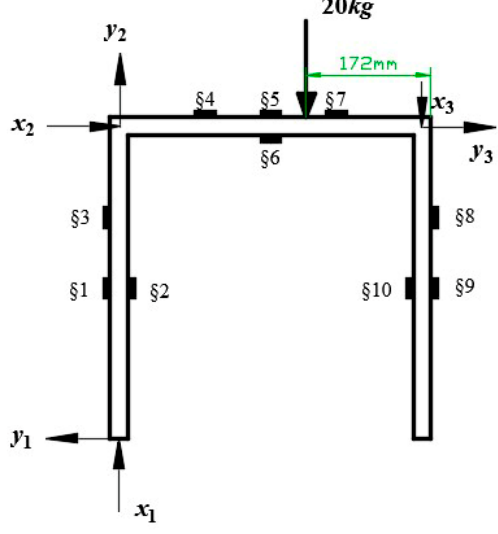
Figure 6. The loading positions and distributions of FBG.